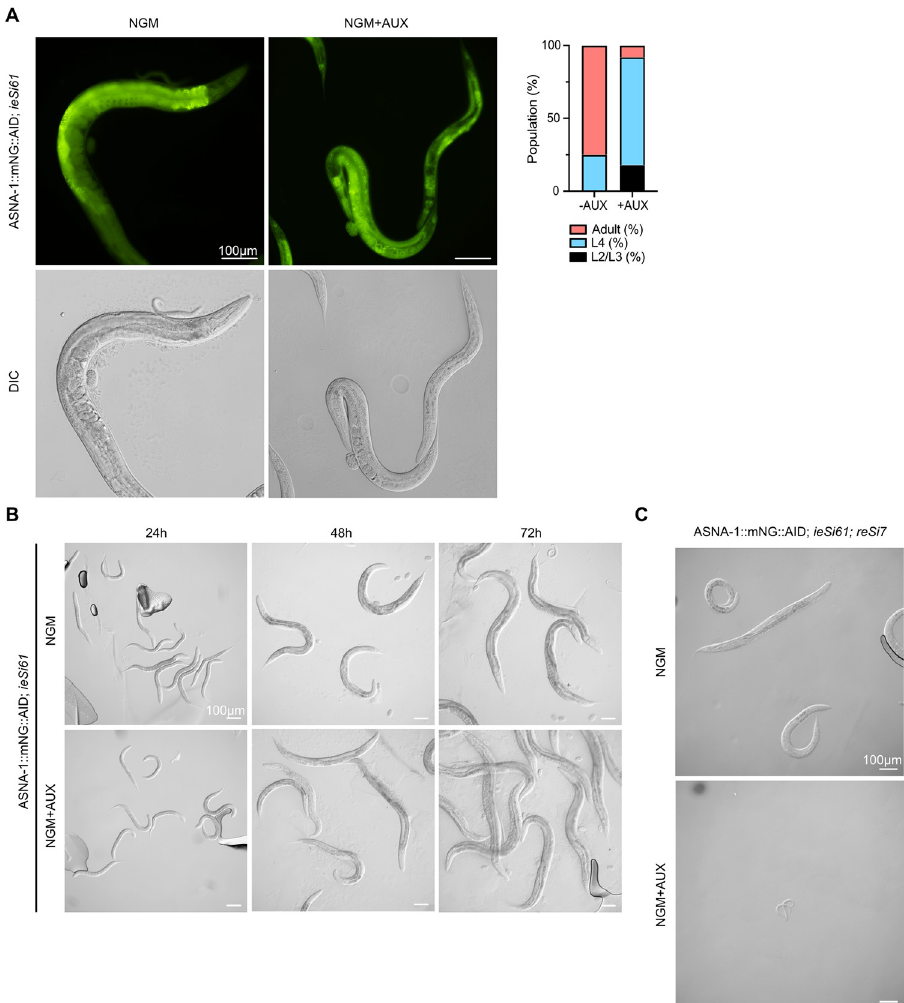
Fig 3. Intestine-specific ASNA-1 depletion leads to a developmental delay. (A) Representative fluorescent and differential interference contrast (DIC) images of worms expressing ASNA-1::mNeonGreen::AID ( syb2249 ) and TIR1 pan-somatic driver ieSi61 grown on plates without (NGM) or with (NGM+AUX) 1mM auxin. The graph represents the quantification of syb2249 ; ieSi61 animals population grown on plates without (NGM) or with (NGM+AUX) 1mM auxin. (B) Schematic representation of second experimental setup for auxin-inducible intestinal ASNA-1 knockdown. Representative DIC images of worms expressing syb2249 ; ieSi61 grown on plates without (NGM) or with (NGM +AUX) 1mM auxin at specific time points. (C) Representative images of auxin-inducible simultaneous intestinal and neuronal ASNA-1 knockdown. Worms were grown on plates without (NGM) or with (NGM+AUX) 4mM auxin. Auxin-exposed progeny (n > 250) displayed the L1 arrest